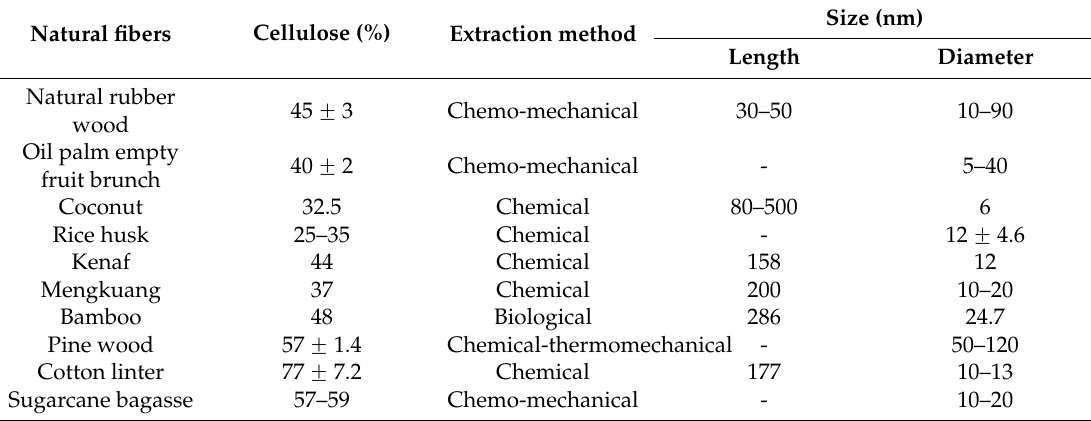
Table 2. The extraction method used on natural fibers, their cellulose content and size [31–40]. Natural fibers Cellulose